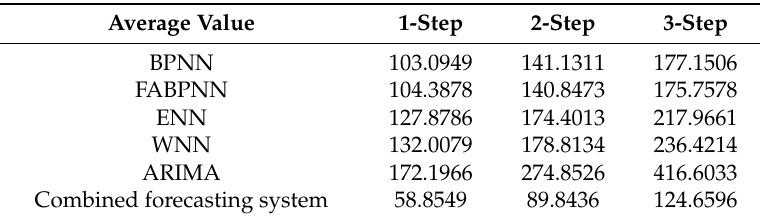
Table 13. Results for the standard deviation of forecasting